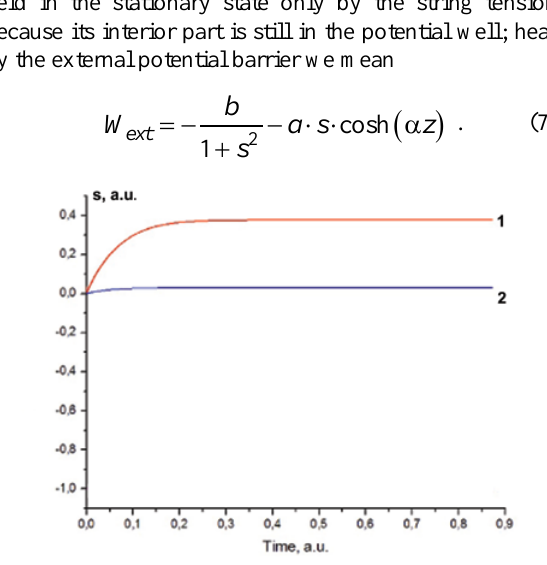
Fig.1a. Drift of the vortex edges under the effect of subcritical current pulse: 1 – s ( t ,1), 2 – s ( t ,0).